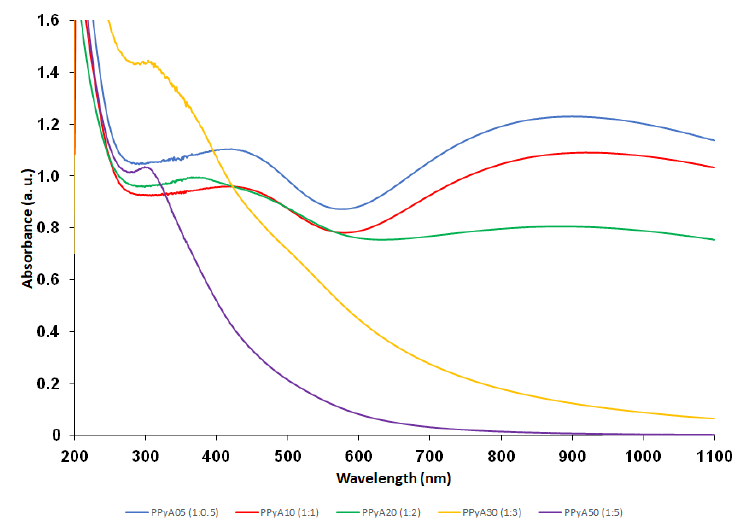
Figure 1. Transmission electron microscopy (TEM) micrographs of the polypyrrole nanoparticles.